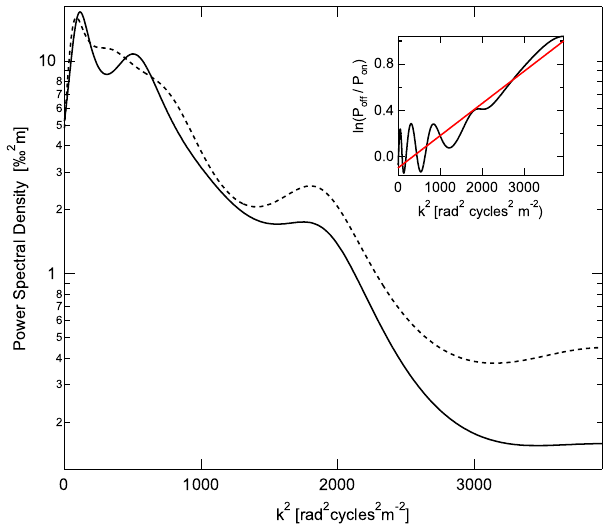
Fig. 9. Calculation of the diffusion length for the transfer function of the CFA system. The dashed and solid lines represent, respectively the power spectral density of the offline discrete data and the CFA data averaged on a 5cm resolution.